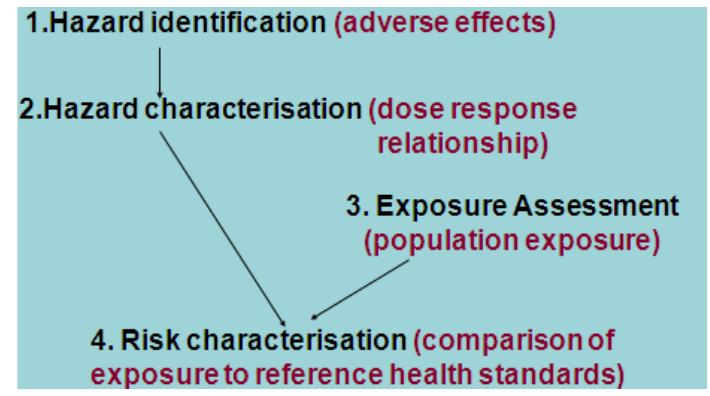
Figure 2. Steps in the Risk Assessment component of the Risk Analysis Framework